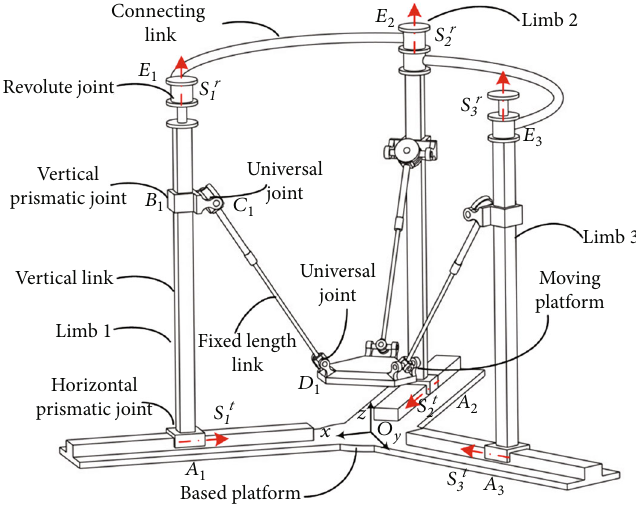
Figure 1: The schematic of the recon fi gurable parallel